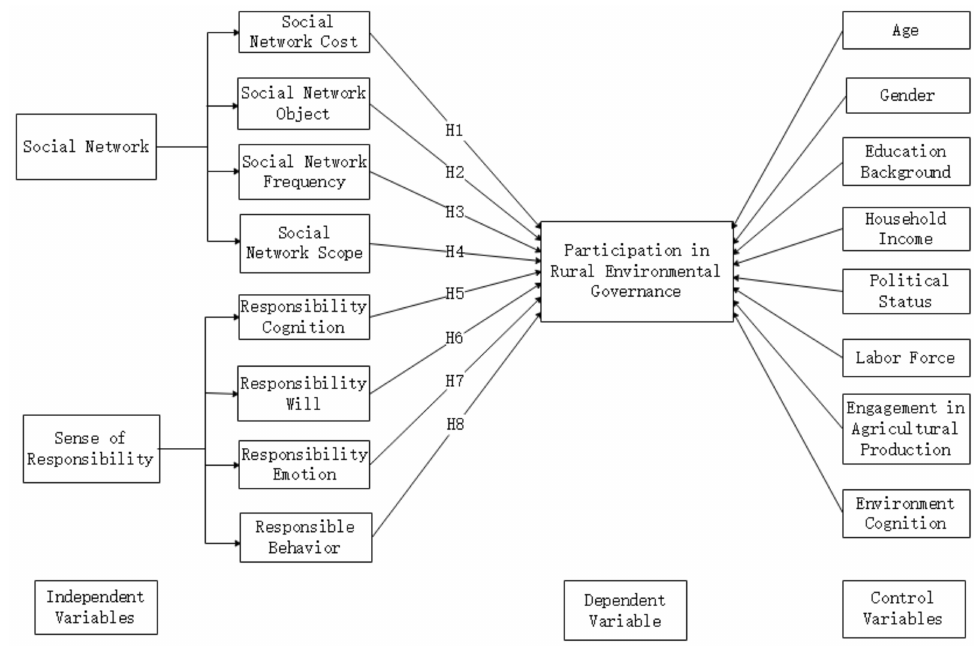
Figure 1. Conceptual